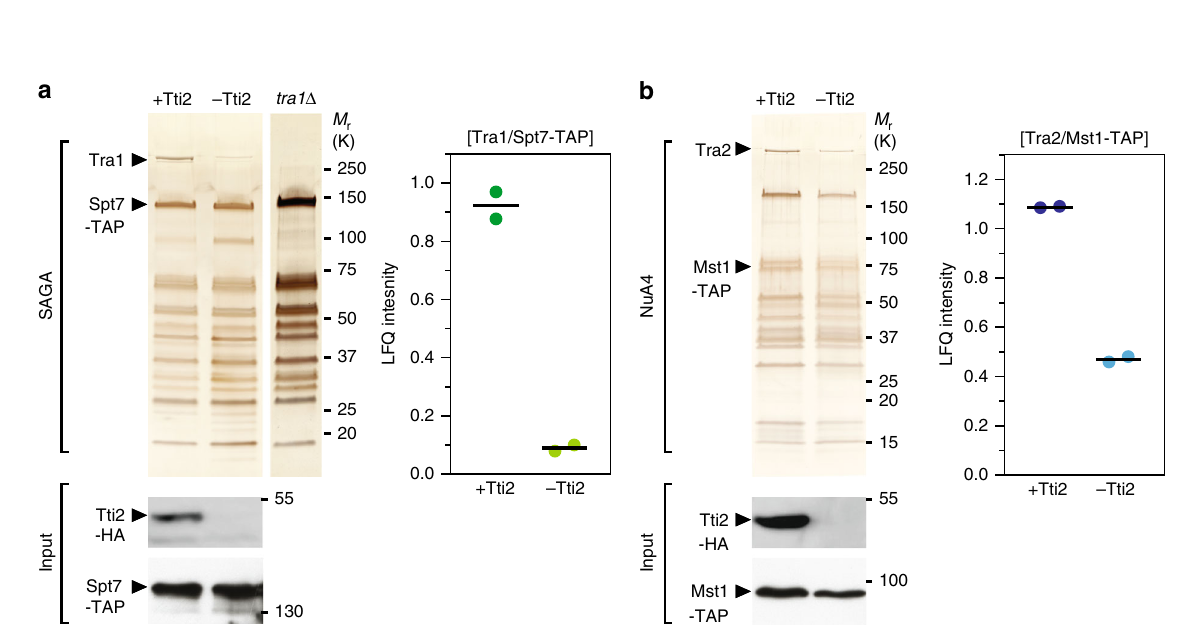
Fig. 2 Tti2 promotes Tra1/Tra2 incorporation into SAGA/NuA4 complexes. a Silver staining of SAGA complexes puri fi ed either in the presence or absence of Tti2 (left). spt7-TAP tti2-CKO cells were grown to exponential phase in rich medium supplemented with either DMSO ( + Tti2) or β -estradiol ( − Tti2) for 18 h. SAGA was puri fi ed from a tra1 Δ strain as a control for the complete loss of Tra1 from SAGA. LC-MS/MS analyses of SAGA puri fi cations (right). LFQ intensity ratios of Tra1 to the bait, Spt7, from two independent experiments are plotted individually with the mean (black bar). Below are anti-HA western blotting of Spt7-TAP and Tti2-HA from a fraction of the input used for TAP. b Silver staining of NuA4 complexes puri fi ed either in the presence or absence of Tti2 (left). mst1-TAP tti2-CKO cells were grown to exponential phase in rich medium supplemented with either DMSO ( + Tti2) or β -estradiol ( − Tti2) for 18 h. LC-MS/MS analyses of NuA4 puri fi cations (right). LFQ intensity ratios of Tra2 to the bait, Mst1, from two independent experiments are plotted individually with the mean (black bar). Below are anti-HA western blotting of Mst1-TAP and Tti2-HA from a fraction of the input used for